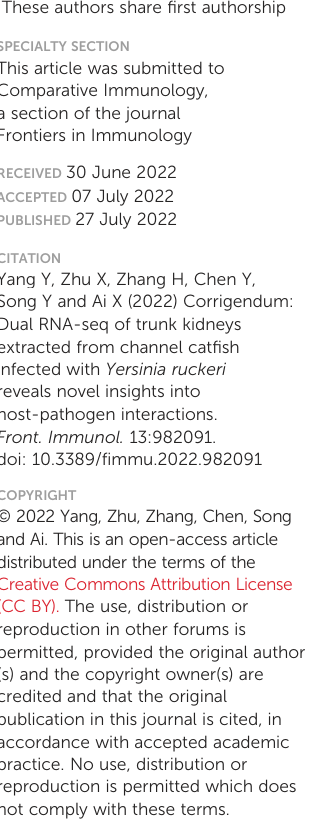
“ Figure 1. The gene expression pro fi les for channel cat fi sh and Y. ruckeri during infection. A volcanic plot depicting the differences in the expression pro fi les of channel cat fi sh and Y. ruckeri . The X-axis represents a log2 (fold change) and the Y-axis